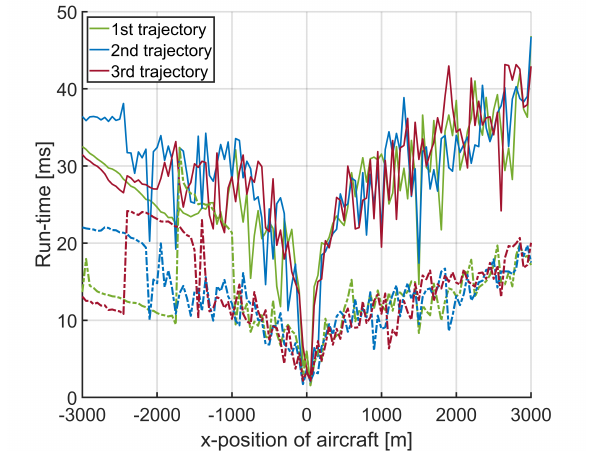
Figure 9. Mean run-times of the adaptive ray zooming method using the same aircraft trajectories as Arntzen (compare to Figure 8.10 in [22]). Solid lines show the results for the basic and dashed lines for the advanced